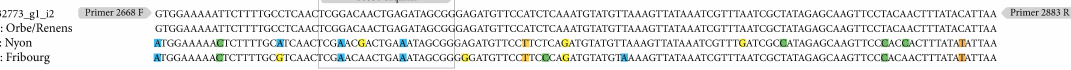
Figure 5. Sequencing results of the di ff erent wild populations. Three di ff erent haplotypes were identified, with point mutations being present in the binding region of the LysV probe. Samples from Orbe and Renens carry the same haplotype ( A ), matching the designed probe, while the samples from Nyon ( B ) and Fribourg ( C ) each have a di ff erent haplotype. The original transcript the primers were designed from can be seen at the top (c32773_g1_i2).